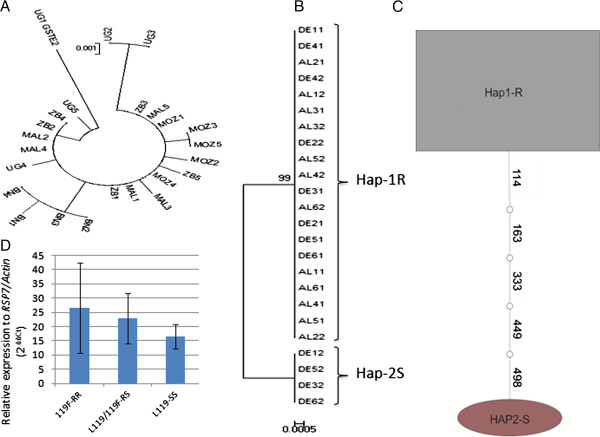
GSTe2 polymorphism and DDT resistance. (A) Maximum likelihood tree of GSTe2 cDNA across Africa. (B) Same as in (A), but with DDT-resistant (AL) and DDT-susceptible (DE) mosquitoes in Benin (genomic DNA). (C)GSTe2 haplotype network (TCS) between susceptible and resistant mosquitoes (Benin). The polygon size reflects the haplotype frequency. Each node represents a mutation (number). (D)GSTe2 expression profile of the three L119F genotypes in Cameroon (Gounougou). BN, Benin; DDT, dichlorodiphenyltrichloroethane; MAL, Malawi; UG, Uganda; ZB; Zambia.